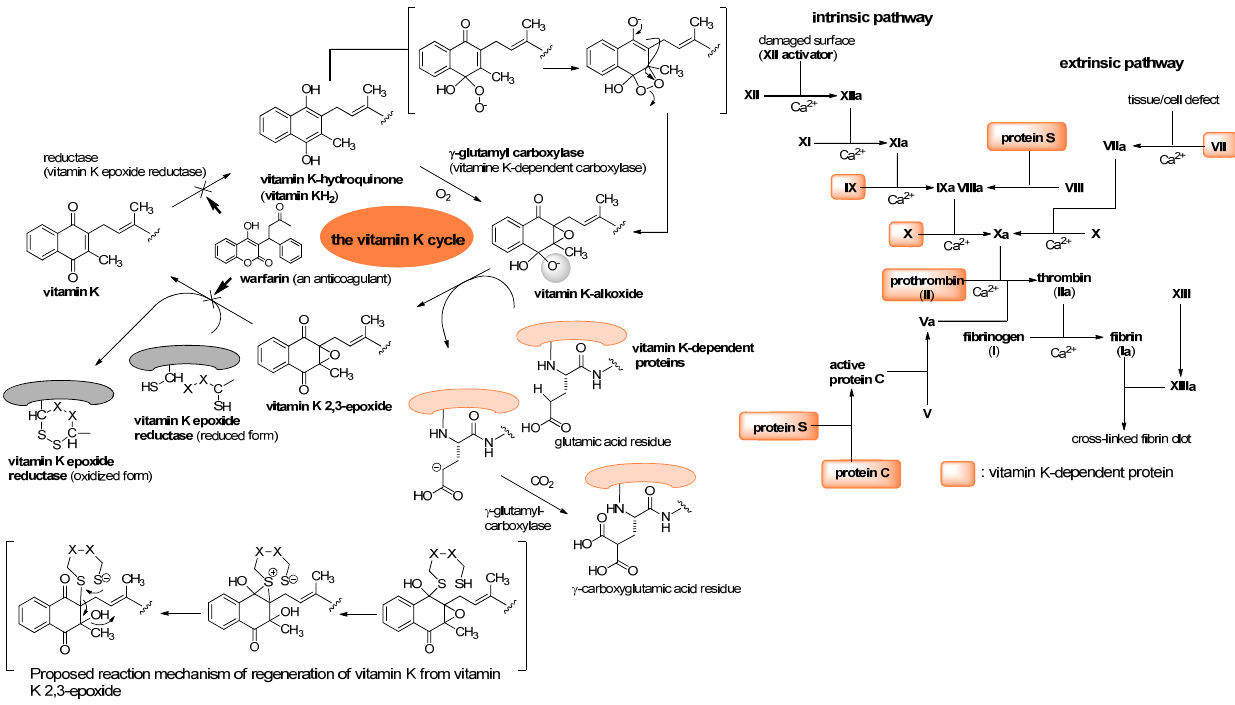
Figure 2. Vitamin K as a cofactor in blood coagulation